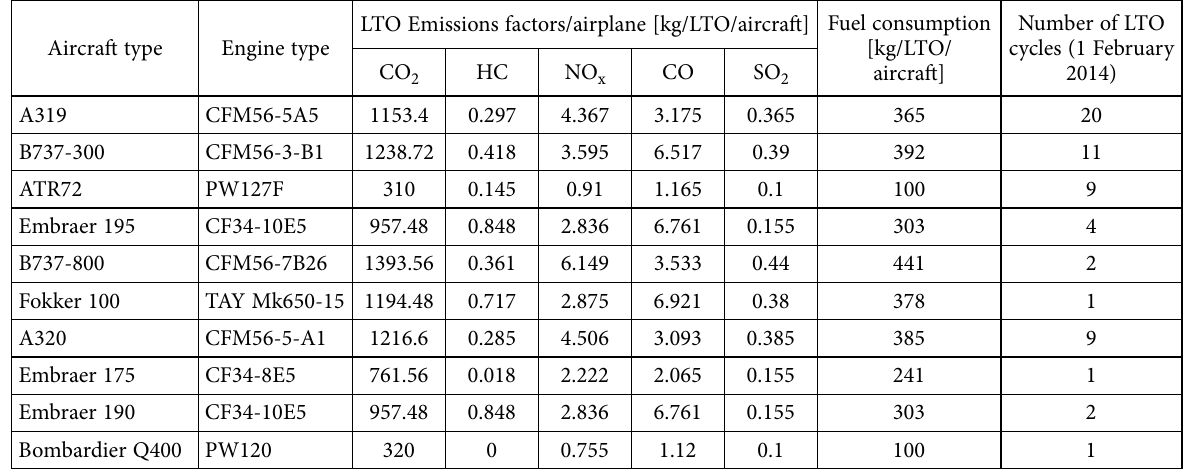
Table 4. Aircraft engine